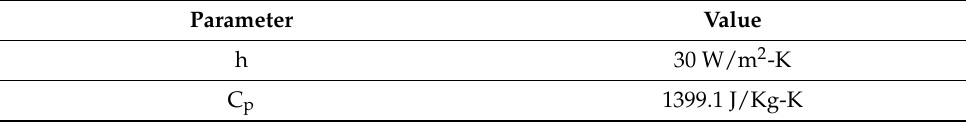
Table 5. 0D Model